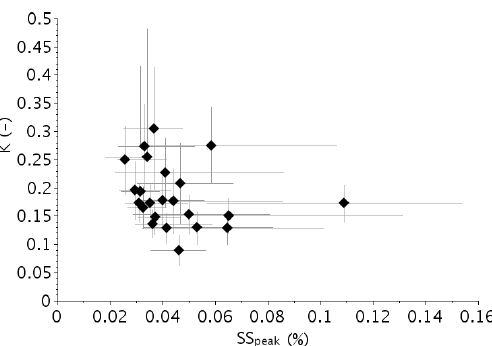
Figure 5. Hygroscopicity parameter κ as a function of the critical supersaturation for the 23 fog events. Diamonds correspond to mean values and error bars to uncertainty